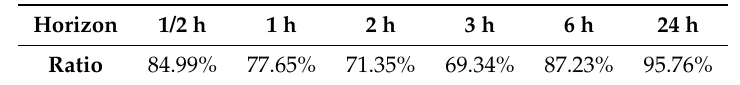
Figure 10. Time evolution of the TEC RMSE, for the case of forecast with the tangent space method (red), and frozen map method (blue) for different horizons (see annotation on the upper part of the figures). Table 2. Ratio of the RMSE between tangent space forecast and frozen maps wrt actual maps for different